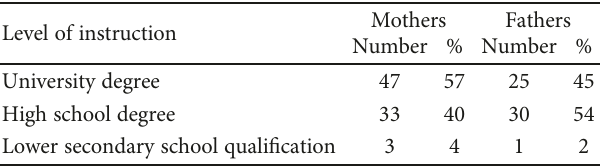
Table 3: Level of instruction of the parents ’ sample. Level of